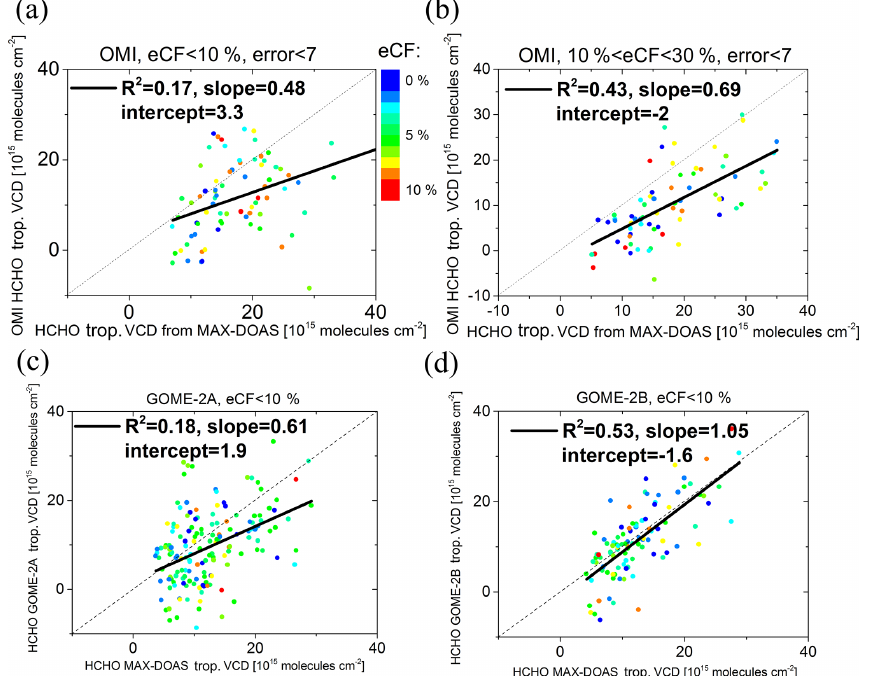
Figure 7. Same as Fig.2, but for HCHO.